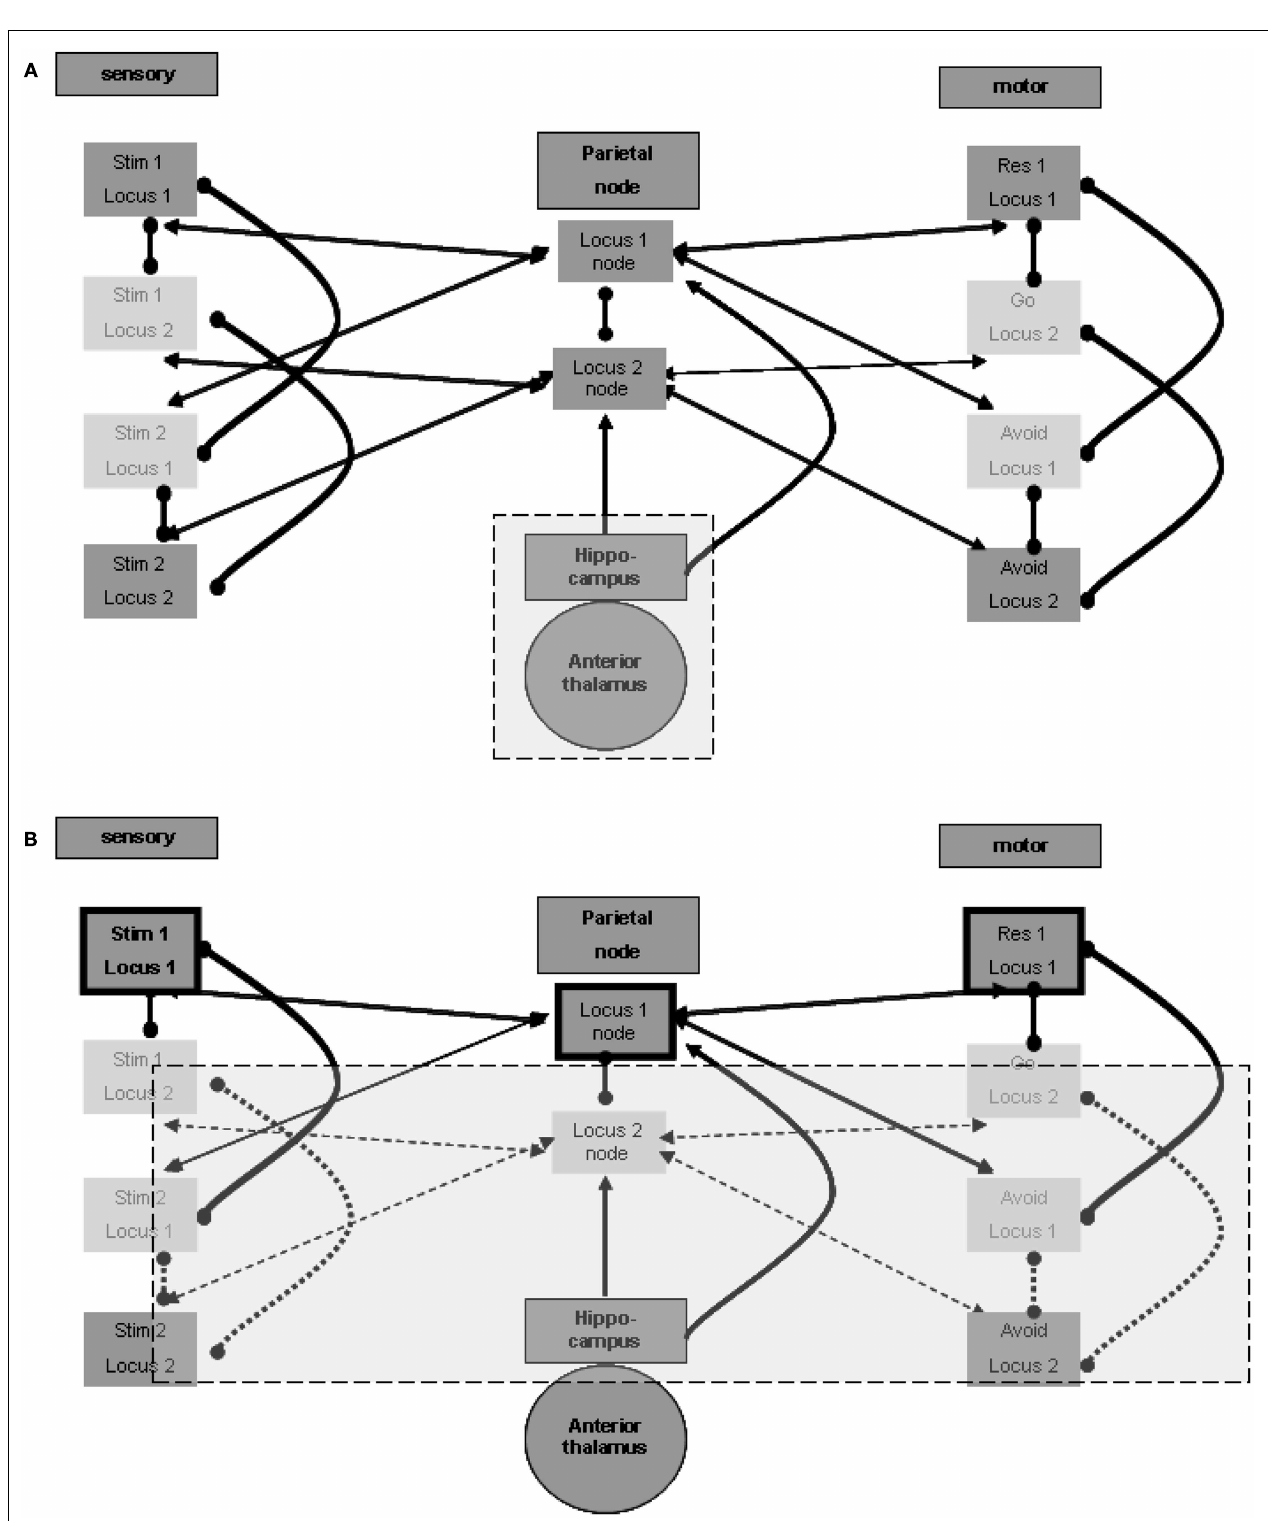
FIGURE 2 | Memory maintenance process . (A) Possible hippocampal contribution for the maintenance of relations. (B) One locus representation without inhibition of the other representation.